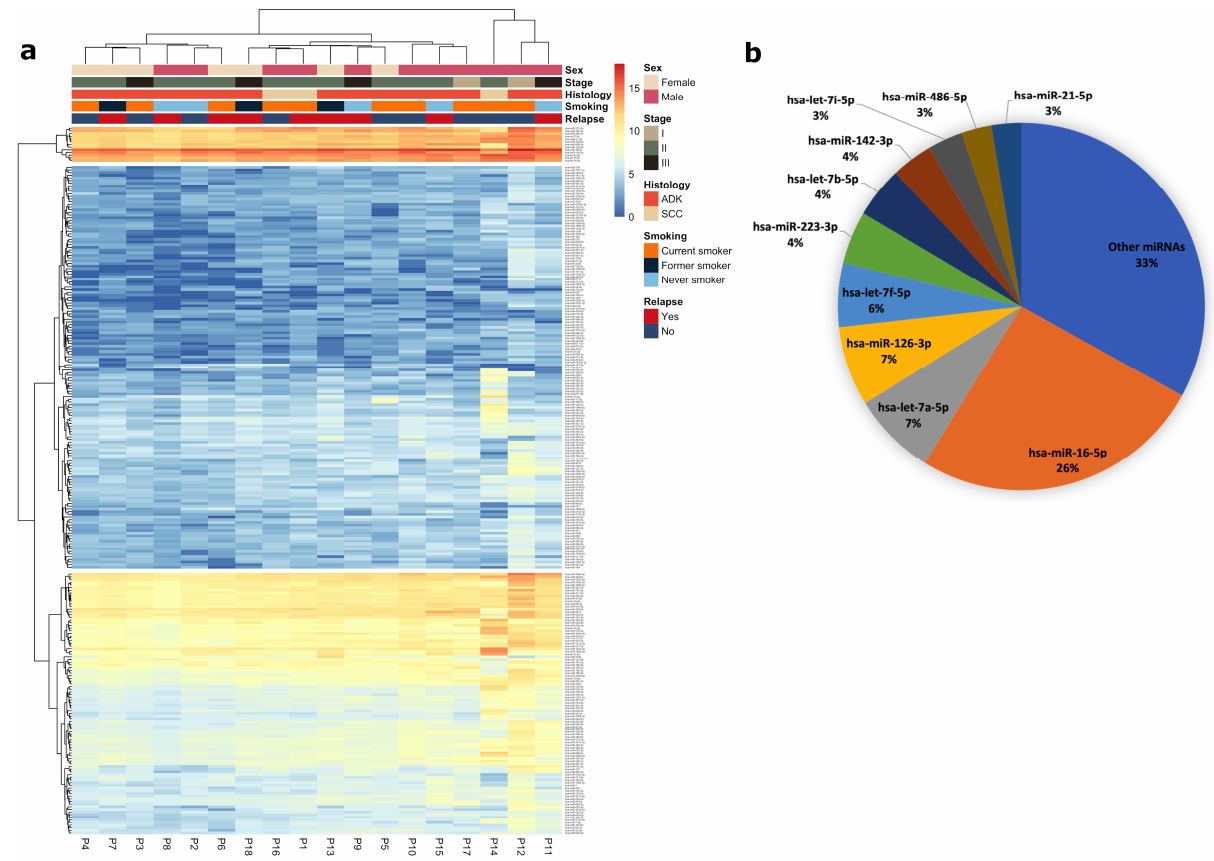
Figure 1. Analysis of the miRNA profile of pulmonary TDV EVs from NSCLC patients: ( a ) Heat map showing the expression (TPM) of the 262 miRNAs detected in the EV from the pulmonary TDV from NSCLC patients. ( b ) Pie chart of the top ten most abundant EV miRNAs identified in pulmonary TDV from NSCLC